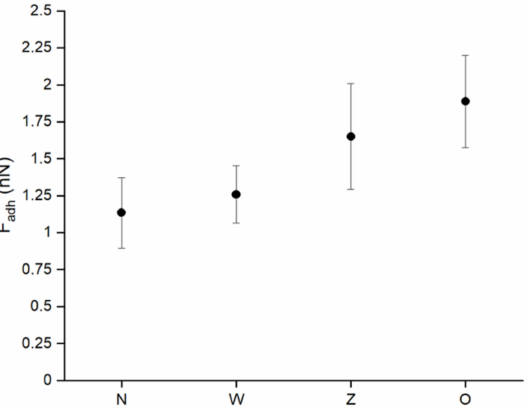
Figure 4. Graph of the averaged blade-surface adhesion force. The black dot means mean value.